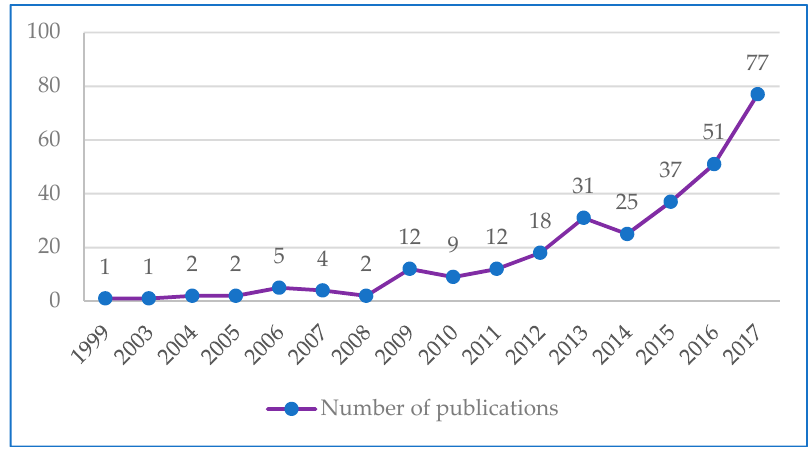
Figure 5. The publications on the topics of “multi-criteria decision making” and “sustainable energy”, 1990–2017.